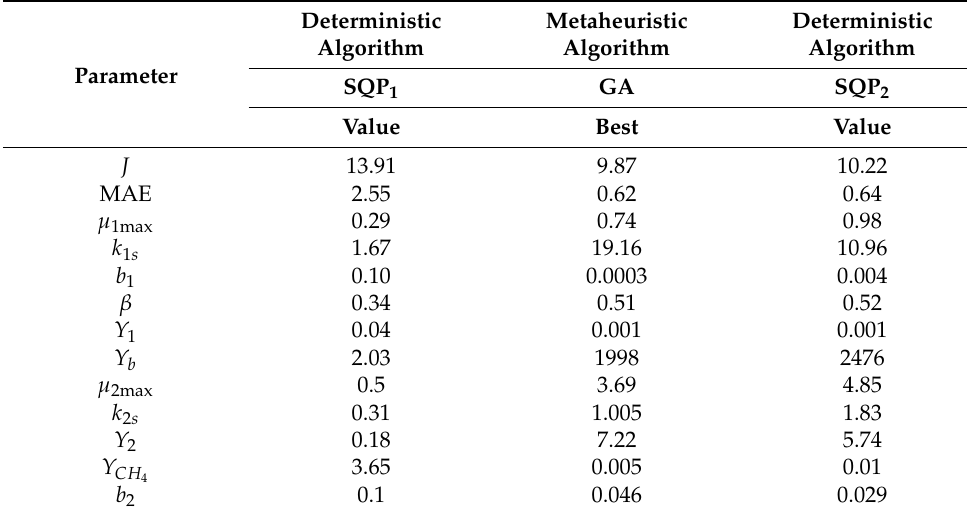
Table 4. Results from model parameter identification based on SQP and